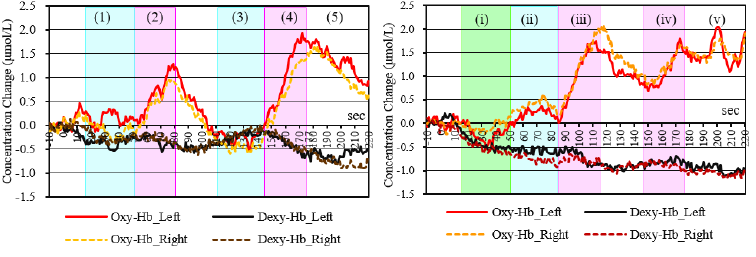
Figure 5. NIRS results when the subjects were conscious of wanting to eat in each cooking movie of STUDY 1; ( 1 ) and ( 3 )/( i ) and ( ⅱ ) cycles show preparatory scenes, such as seasoning and shaping ingredients, and ( 2 ) and ( 4 )/( ⅲ ) and ( ⅳ ) show sizzling-simmering scenes.